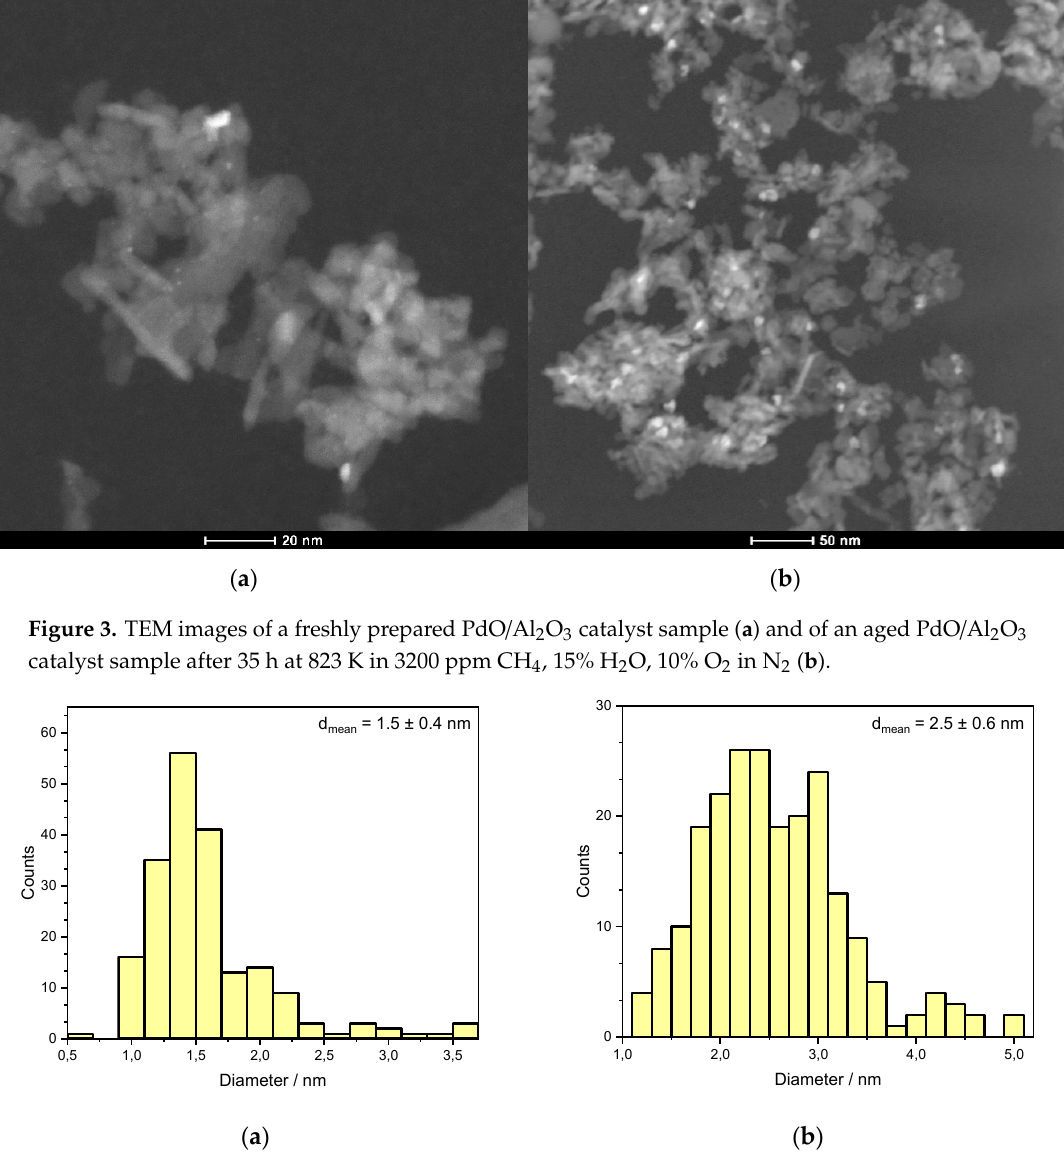
Figure 4. Particle size distributions of a freshly prepared ( a ) and aged ( b ) PdO/Al 2 O 3 catalyst as shown in Figure 3, obtained by analysis of > 200 particles.